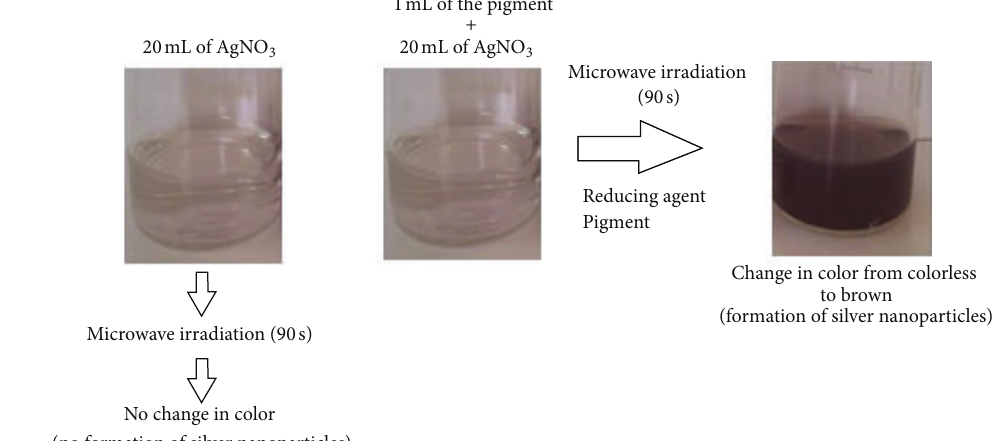
Figure 2: Pathway for the synthesis of silver nanoparticles.